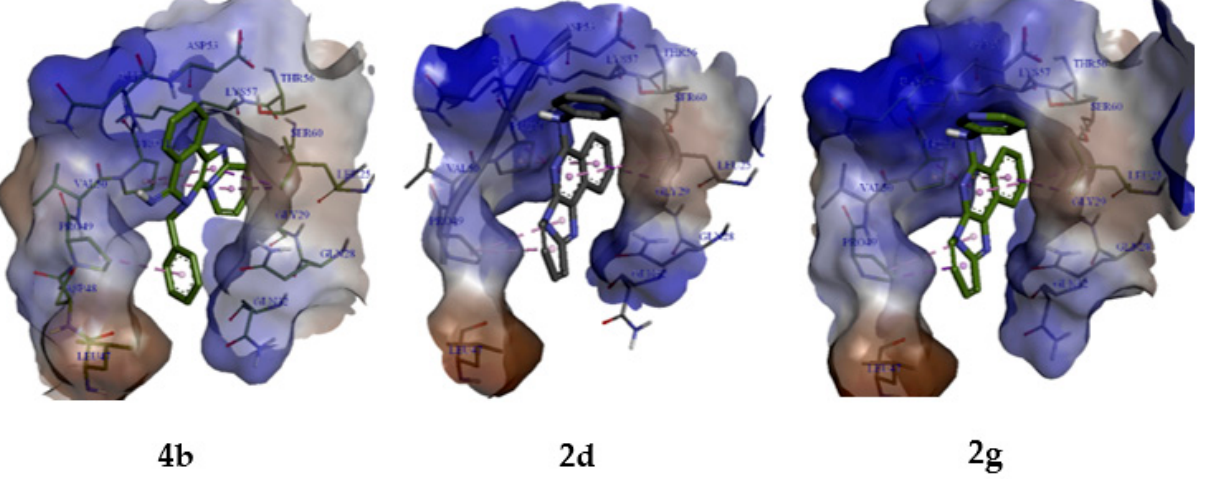
Figure 7. Hydrophobic area as exhibited by the active site along with compounds 2d , 2g and 4b .